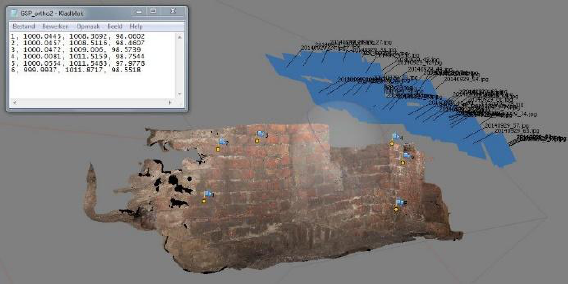
Figure 6. Brick wall dated circa 1250. Modelled with Photoscan, scaled and referenced using coordinates measured